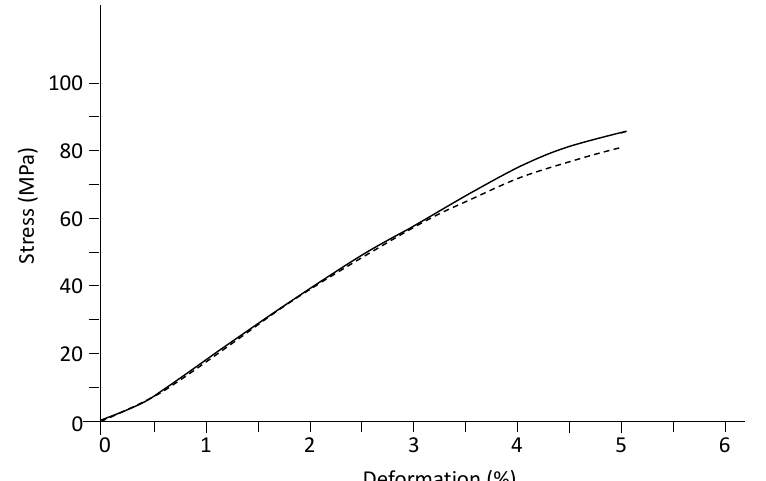
Figure 7. Stress–strain curves (average values) from the three-point bending flexural test for the DGEBA/mXDA system: without AuNPs (dashed line) and with AuNPs (8.5%) (solid line).